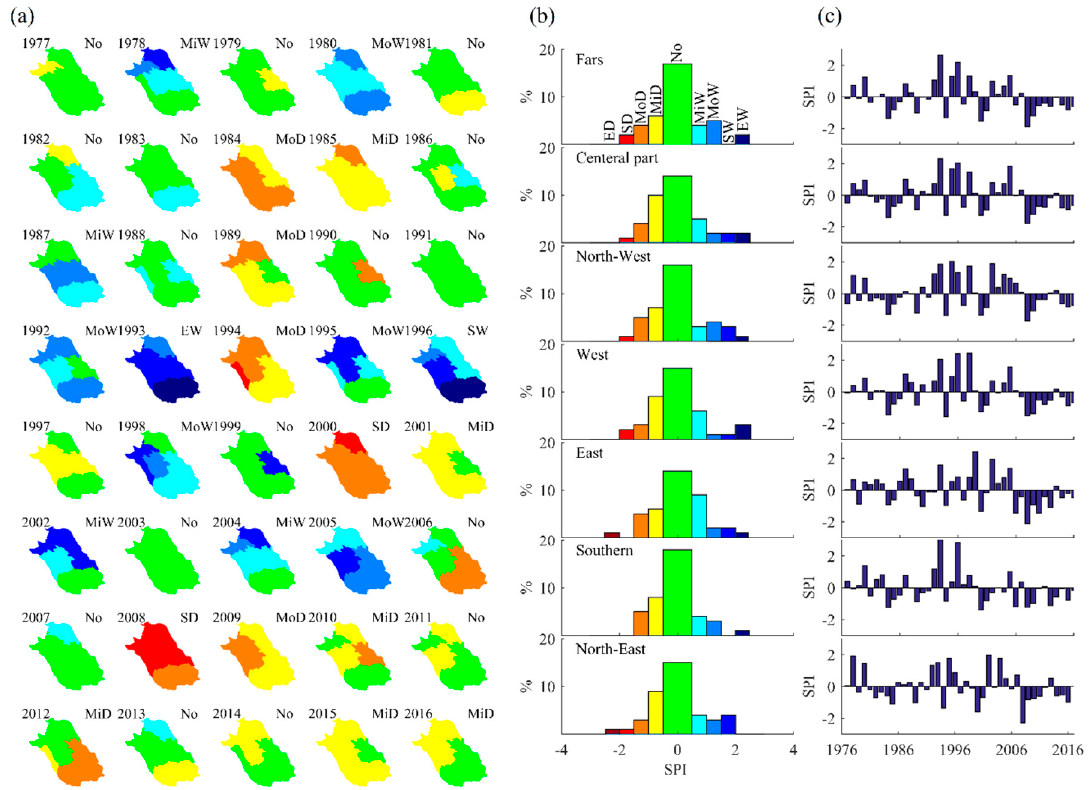
Figure 4. ( a ) Spatio-temporal distribution of meteorological drought (standardized precipitation index, SPI) in the six regions of Fars province, (1977–2016). ( b ) Histogram of SPI classes and ( c ) annual variation in SPI in Fars and its regions. SPI classification: EW: extremely wet, SW: severely wet, MoW: moderately wet, MiW: mildly wet, No: normal conditions, MiD: Mildly dry, MoD: moderately dry, SD: severely dry, ED: extremely dry.